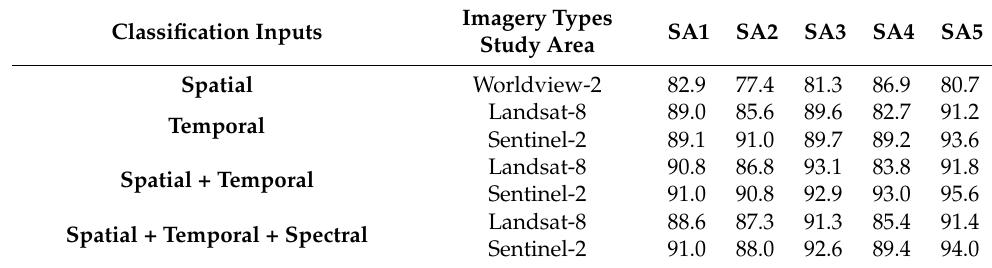
Table 8. The optimal vineyard classification OA (%) obtained using different classification inputs (where the OA of spatial + temporal + spectral classification input was obtained when approaching saturation with temporal